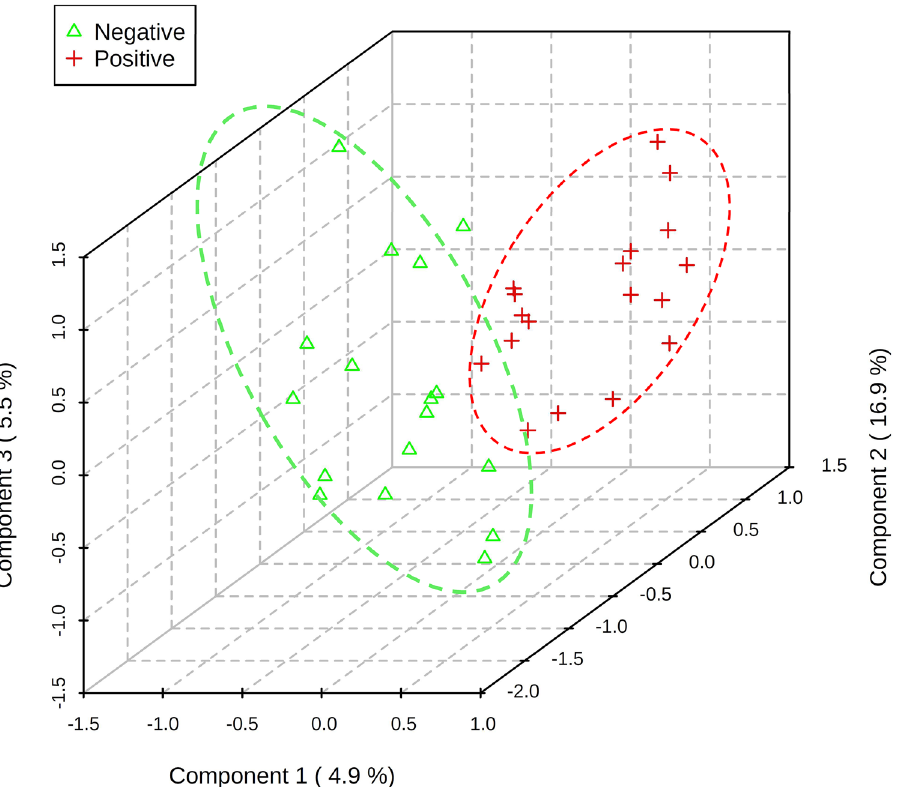
Figure 5. The 3D score plot shows a clear distinction in VOC between lung cancer patients with and without EGFR mutations. The red plus symbols indicate lung cancer patients with EGFR mutation. The green triangle symbols indicate lung cancer patients without EGFR mutation. The explained variances are shown in